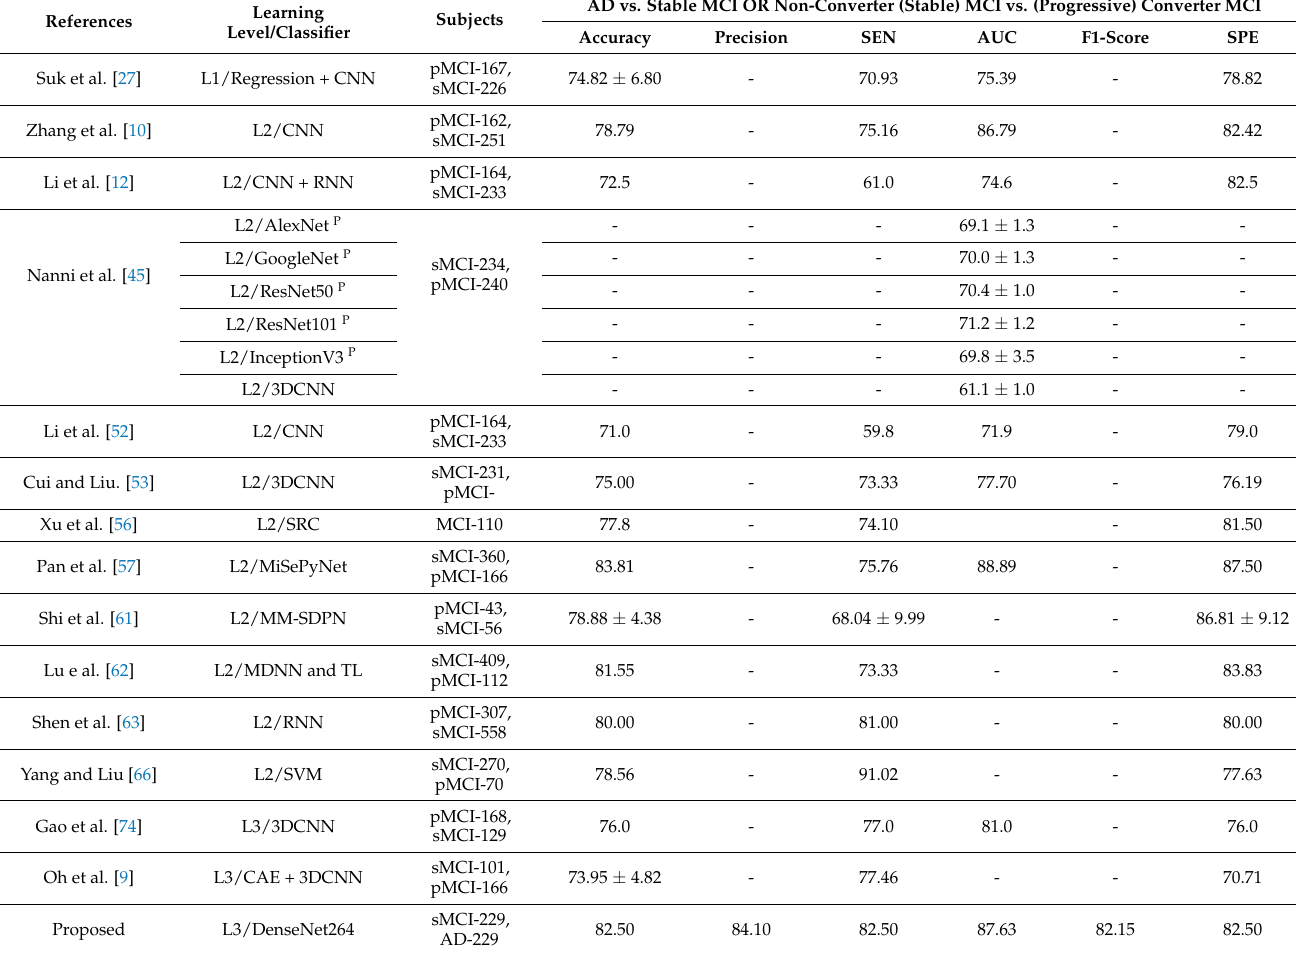
Table 15. Classification (AD vs. sMCI and sMCI vs. pMCI) performance of the published state-of-the- art